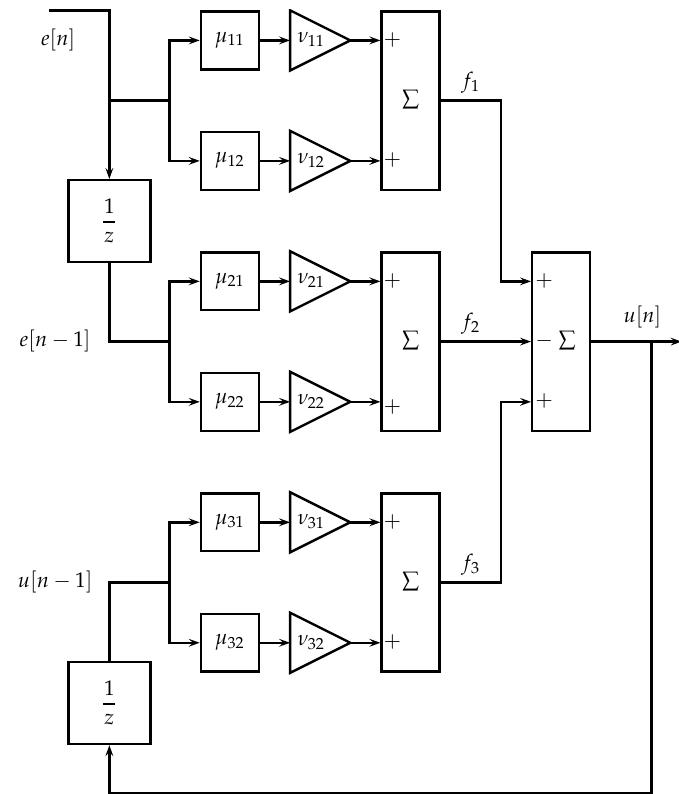
Figure 12. Neuro-fuzzy control system